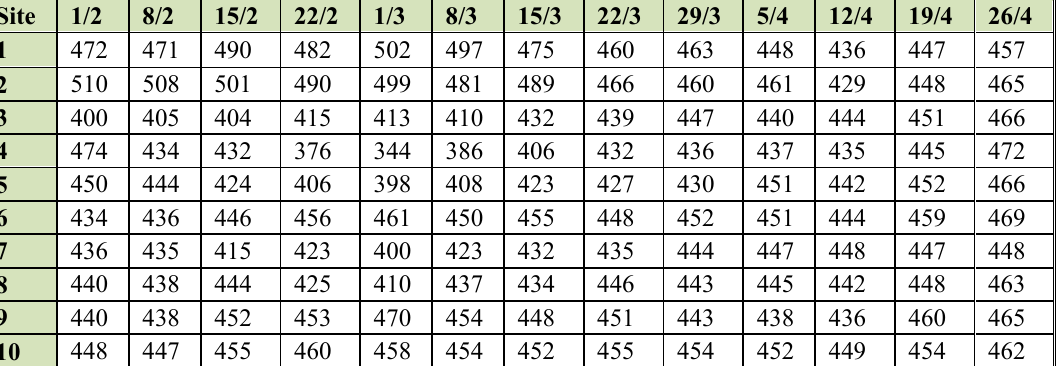
Table 7: Total dissolved solid values (ppm).